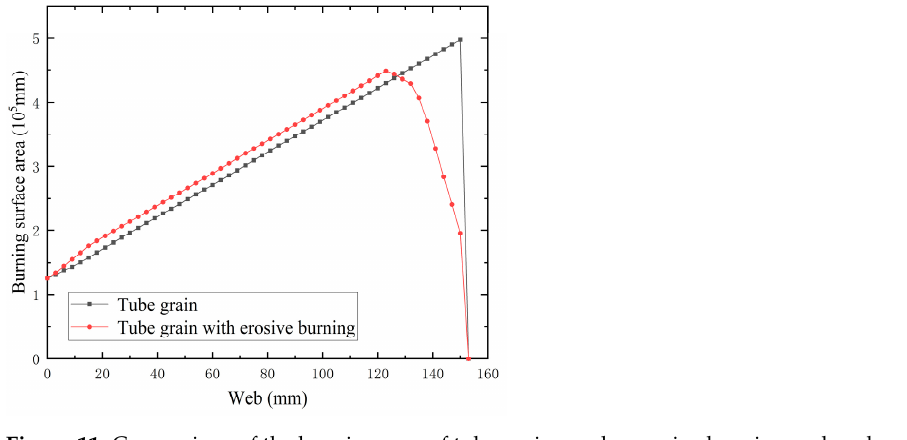
Figure 11. Comparison of the burning area of tube grains under erosive burning and under geometri- cal law of burning.